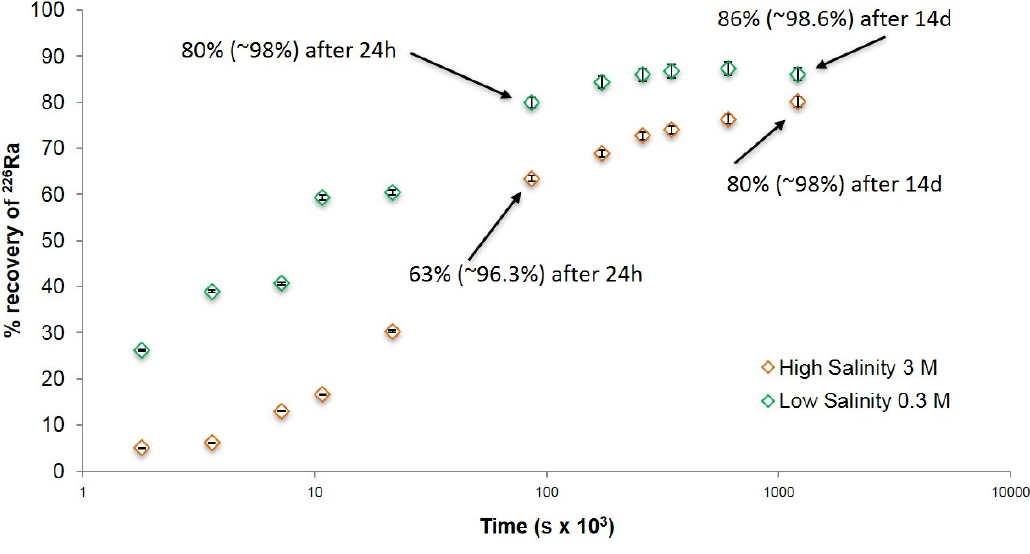
Figure 3. 226 Ra recovery by barite post-precipitation. Low Salinity: 0.3 M NaCl with 0.22 mM barite (0.22 mM Ba 2+ + 1.5 mM SO 42 − ); High Salinity: 3 M NaCl with 0.22 mM barite (0.22 mM Ba 2+ + 15 mM SO 42 − ). The values in parentheses show overall removal (co-precipitation (maximum of 90%) plus post-precipitation uptake). 2 σ error is based on counting statistics only.